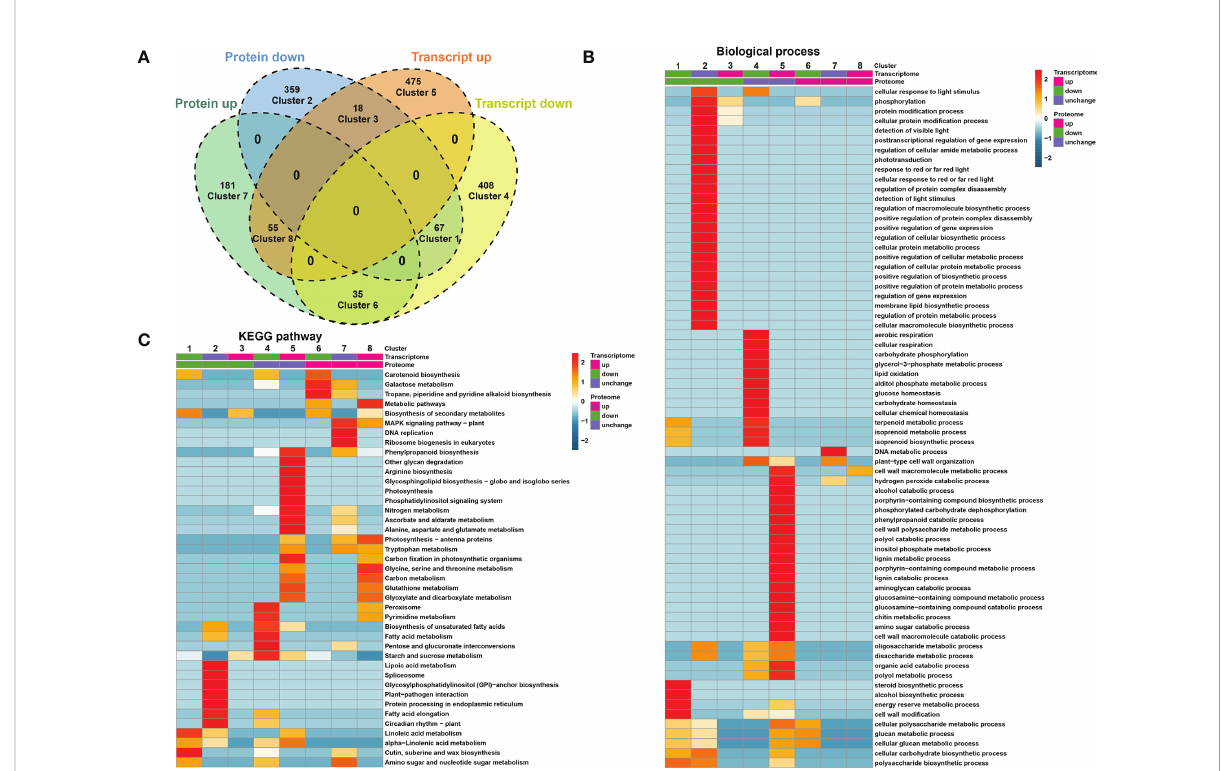
FIGURE 3 Correlation analysis between DEGs and DEPs. (A) Venn diagram showing that DEGs and DEPs are divided into 8 differential expression clusters. (B) Gene Ontology (GO)-based enrichment analysis of differential expression clusters in biological process class. (C) KEGG enrichment analysis of differential expression